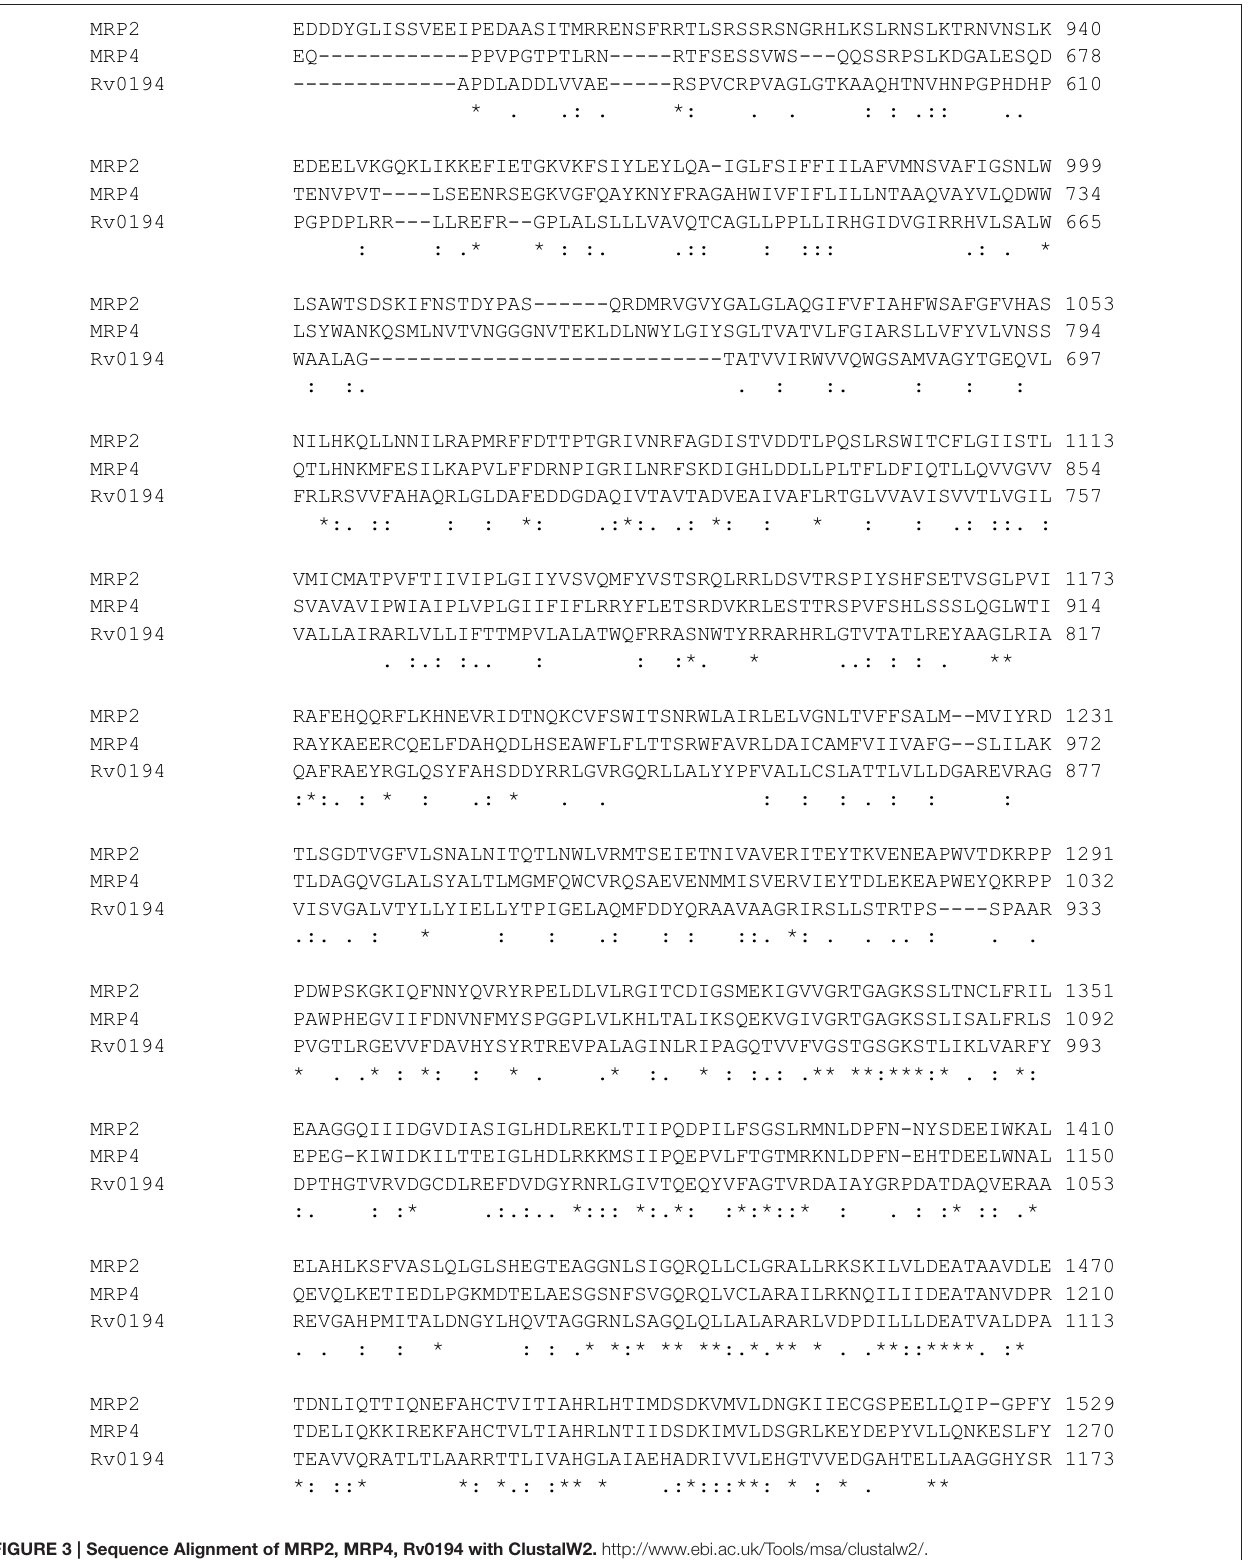
Frontiers in Microbiology | www.frontiersin.org